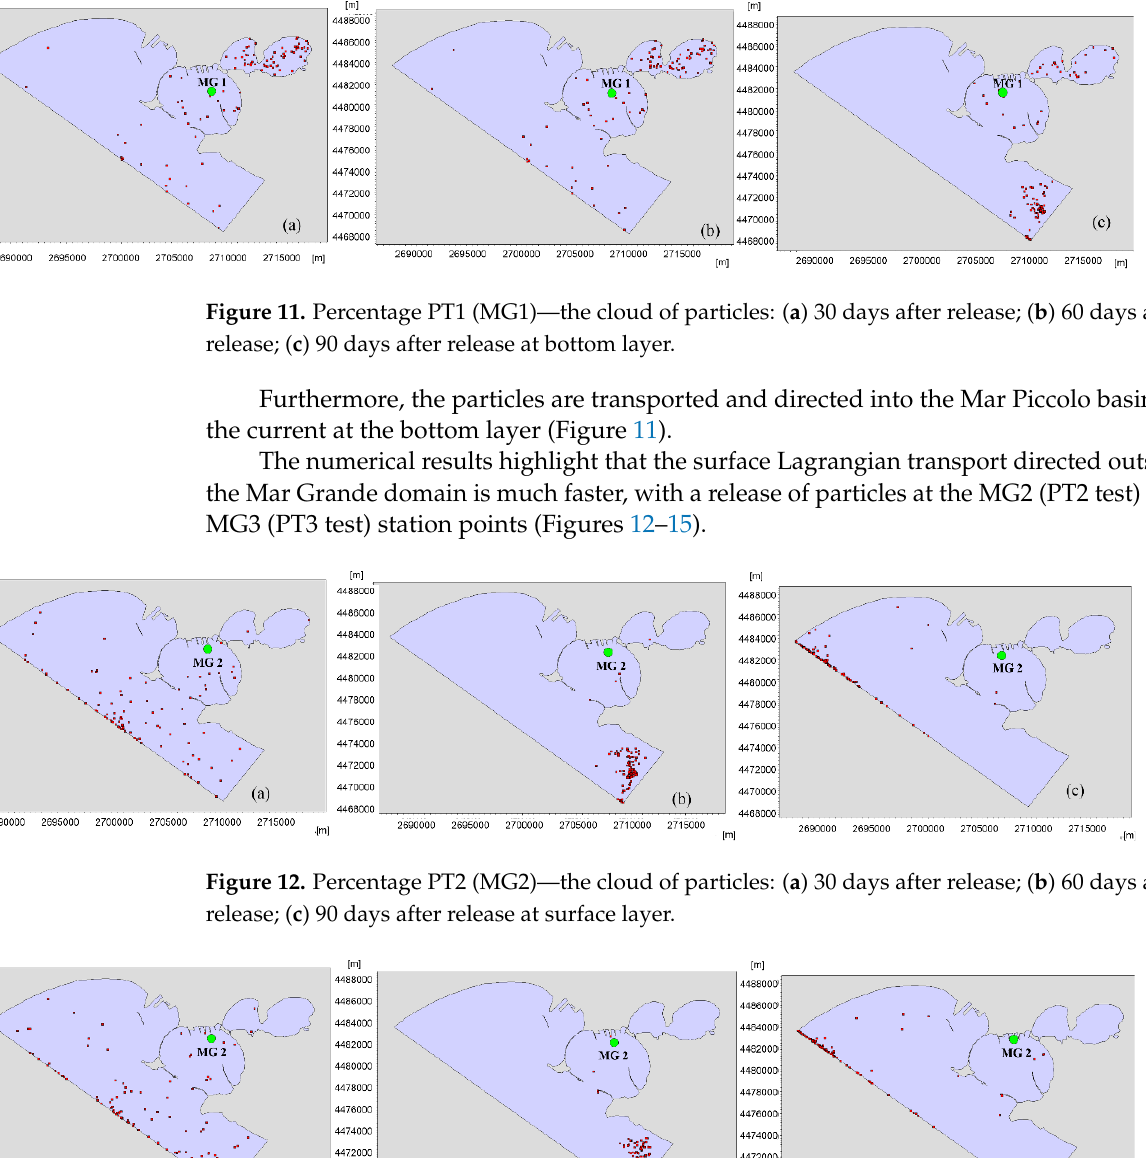
Figure 13. Percentage PT2 (MG2) — the cloud of particles: ( a ) 30 days after release; ( b ) 60 days after release; ( c ) 90 days after release at bottom layer.